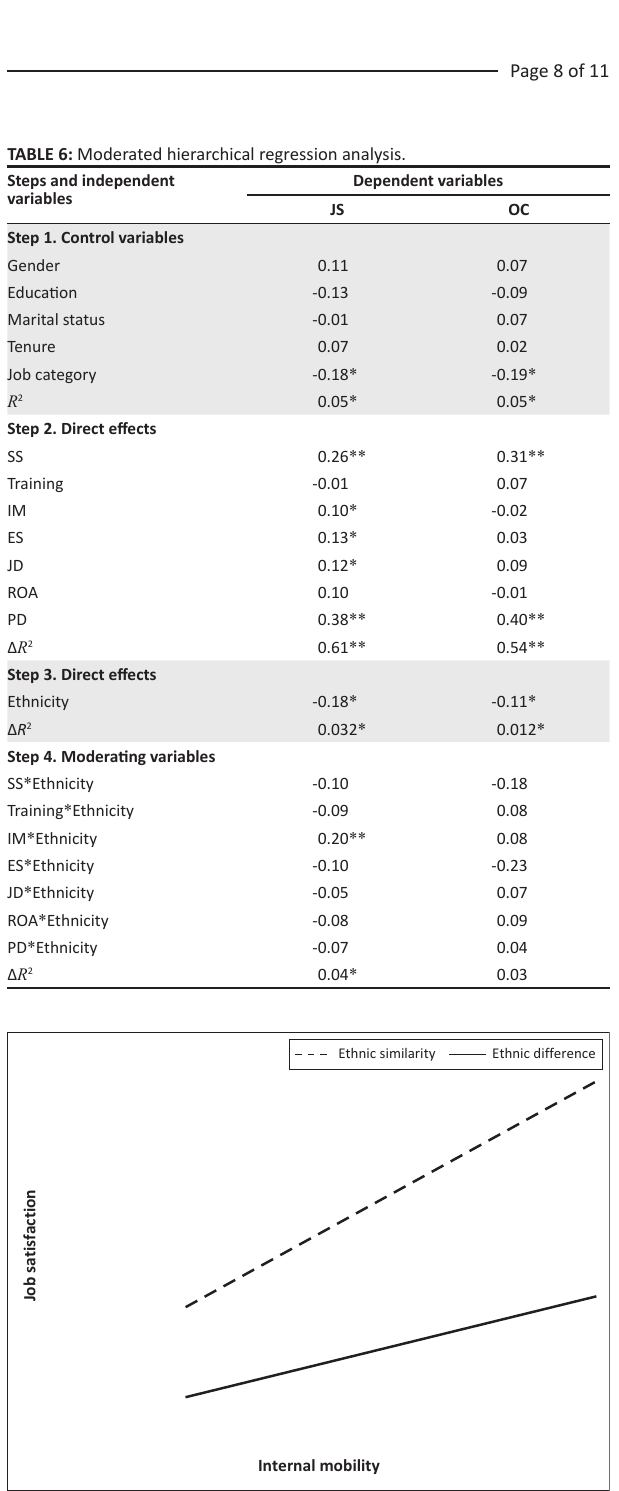
FIG URE 2: Interactive effect of ethnic similarity or difference on internal mobility and job